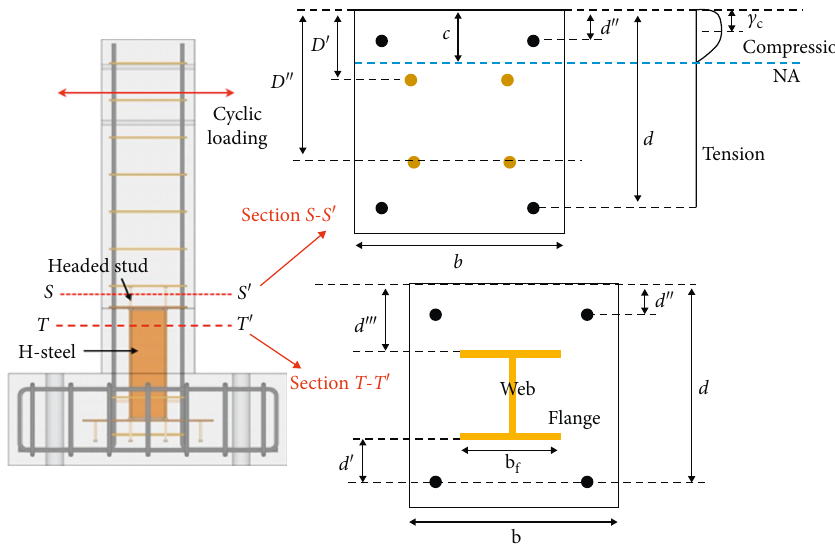
Figure 4: Cross sections used to derive equations (1), (3), (4), and